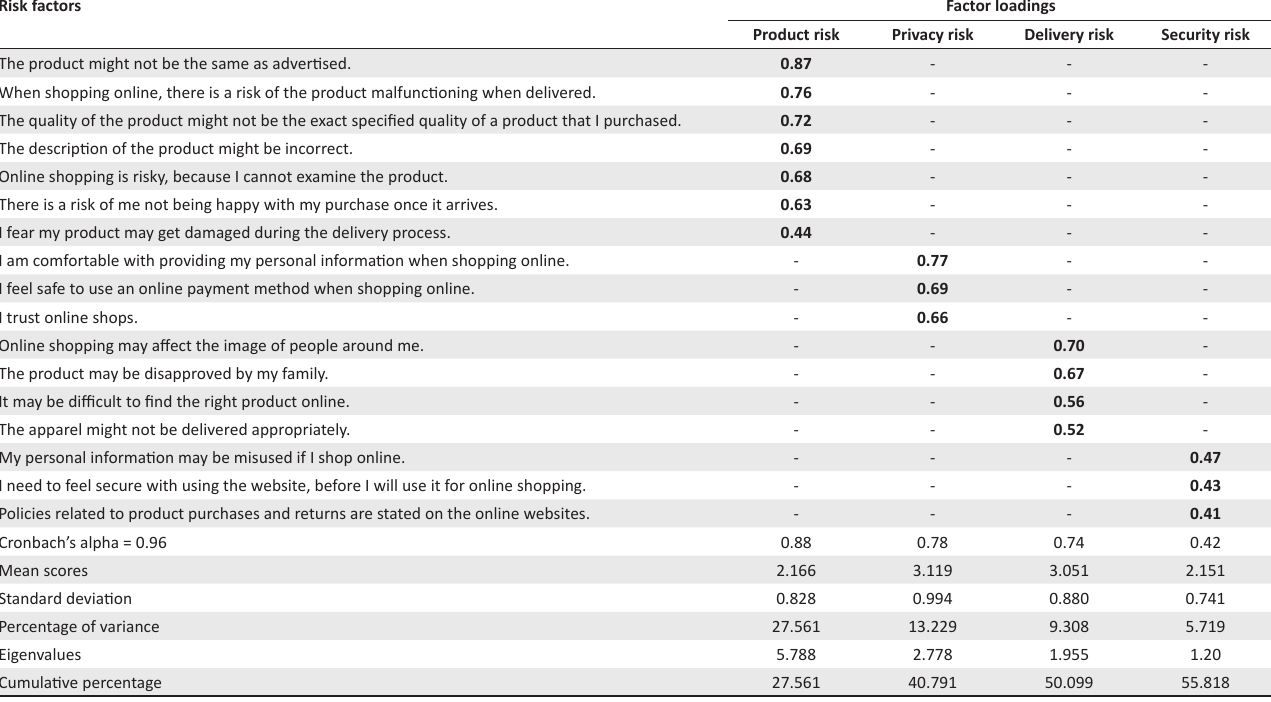
TABLE 2: Factor analysis and communalities. Risk